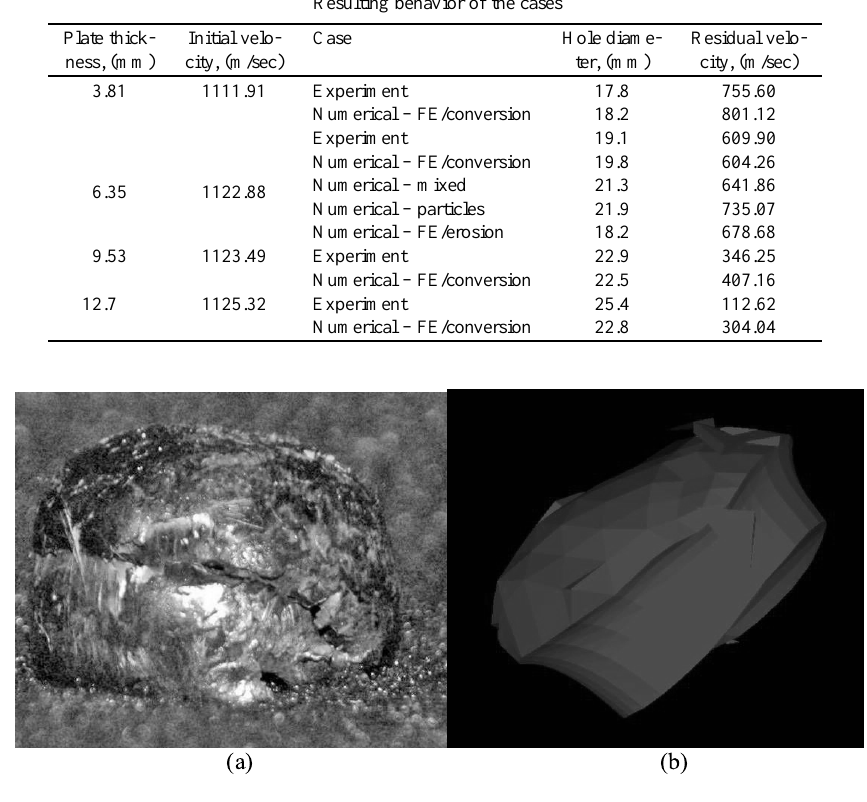
Fig. 8. Comparison of deformed FSP (a) experiment, and (b) simulation. strain. The scale shown for velocity (V scale in the plots) applies to the penetrator only, while the scale for damage only applies to the target plate. Damage is set on a scale from zero to 1.0 (which is approximately the failure strain). The velocity is higher when a mesh consisting entirely of particles was used, while the residual velocity from the other two cases was relatively close. Damage to the plate was consistent throughout the simulations, exhibiting very little damage away from the hole generated in the